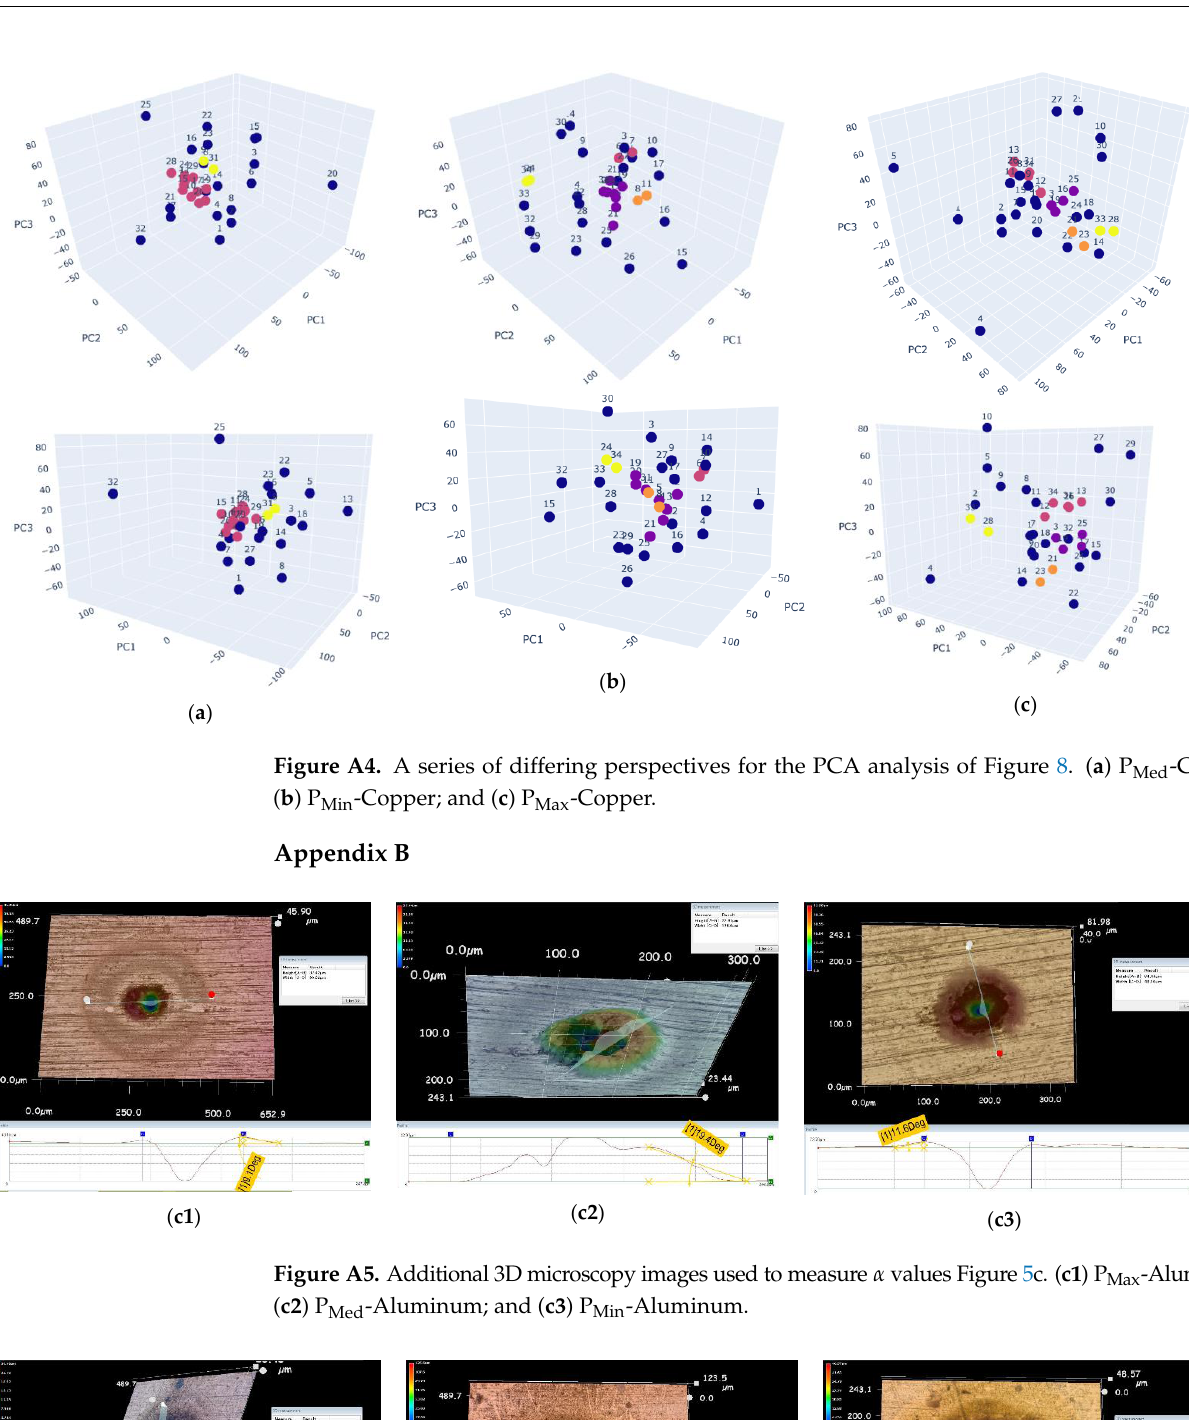
Figure A3. A series of differing perspectives for the PCA analysis of Figure 7): ( a ) P Max -Aluminum;